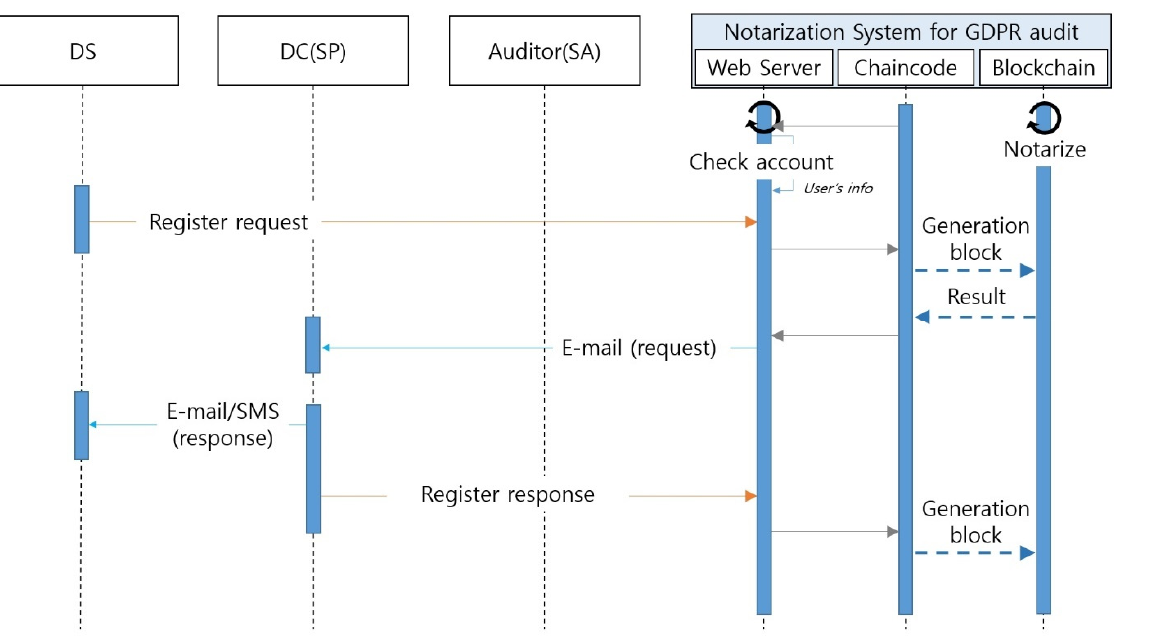
Algorithm 3 Input